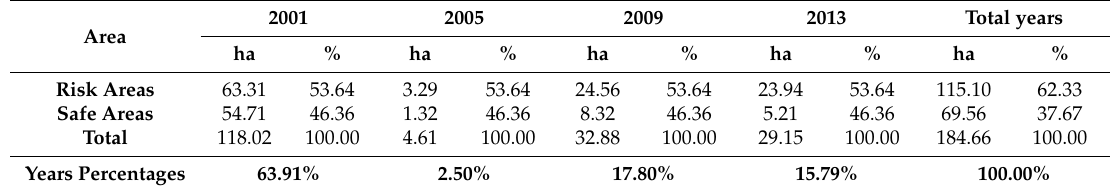
Figure 7. Map showing the at risk areas, the safe areas, and the watershed boundaries for the study area. Table 2. Urban distribution in areas deemed to be either safe or at risk from potential